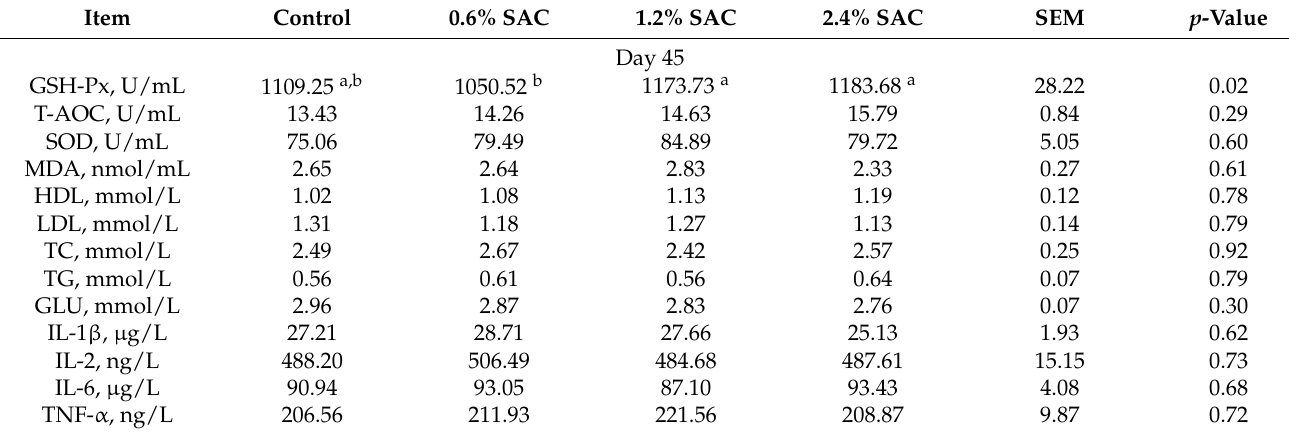
Table 8. Effects of dietary Selenium Auricularia cornea culture supplementation on serum profile of pigs in Exp. 2. Item